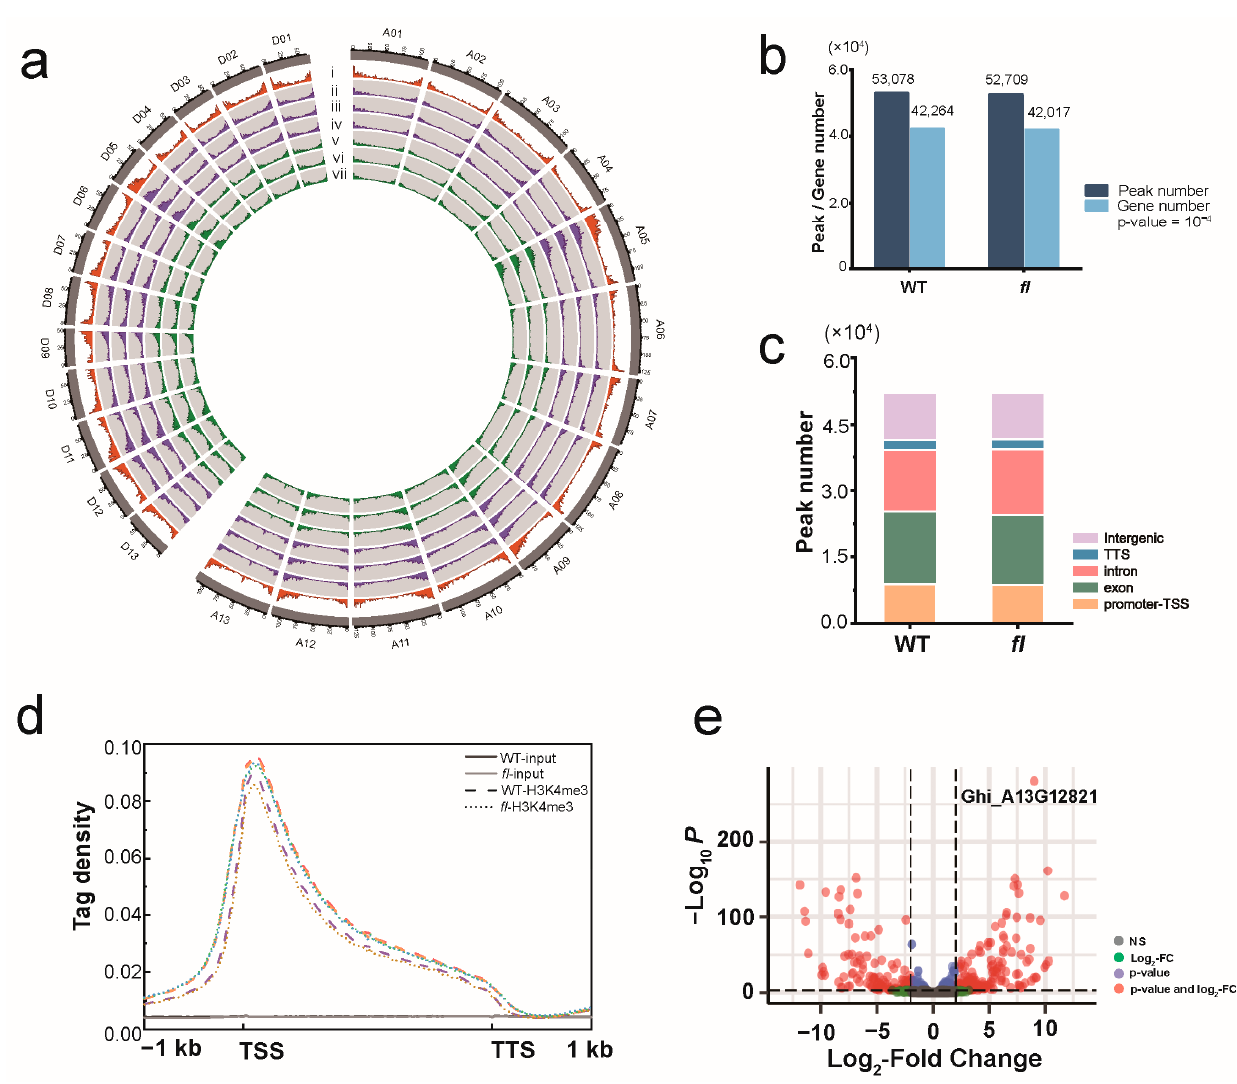
Figure 1. Global analysis of H3K4me3 distribution in WT and fl . ( a ) Overview of H3K4me3 ChIP-Seq signals along the whole genome. i, gene density; ii~iv, H3K4me3 ChIP-Seq signals from 3 replicates in WT; v~vii, H3K4me3 ChIP-Seq signals from 3 replicates in fl . ( b ) Total peak numbers and gene numbers marked with H3K4me3 in WT and fl of three replicates, p -value = 10 − 4 . ( c ) Distribution of H3K4me3 in different functional sub-genomic annotations, namely, promoters-TSS (upstream 1 kb), exons, introns, TTS (2 kb), and distal intergenic regions. Data was generated using three or two replicates for ChIP samples or input samples, respectively. ( d ) Distribution of H3K4me3 along up- land cotton genes in WT and fl. A meta-gene profile was generated using the normalized sequencing density of H3K4me3. The gene body was converted into a percentage with the aim to standardize genes of different lengths. The 1 kb upstream and downstream regions of each gene are included. The signals from the duplicates or triplicates are shown. ( e ) Volcano plots of identified genes cov- ered with H3K4m3 signal in WT and fl , respectively. Genes enriched significantly in either WT or fl are depicted in red (|Fold change| ≥ 2, p -value < 0.05).